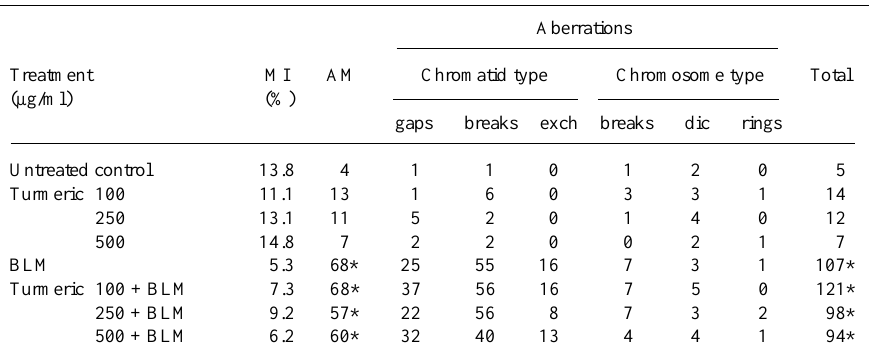
Table III - Distribution of the different types of chromosomal aberrations in 300 cells analyzed per group of treatment and mitotic index y (MI) observed in CHO cells after treatment with turmeric (4 h) and/or bleomycin (BLM, 10 µg/ml) during G /S 2